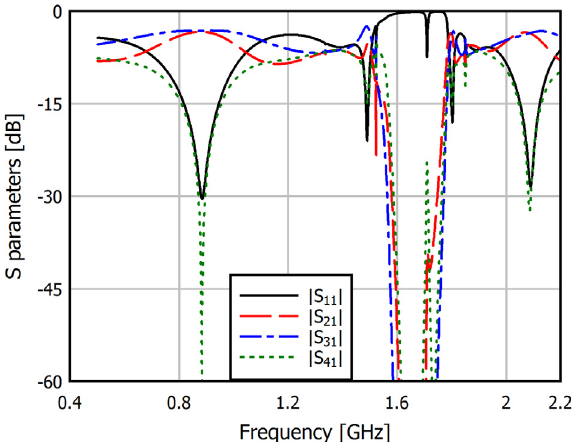
Figure 9. Simulated S -parameters of the tri-band BLC using the single port sub-circuit